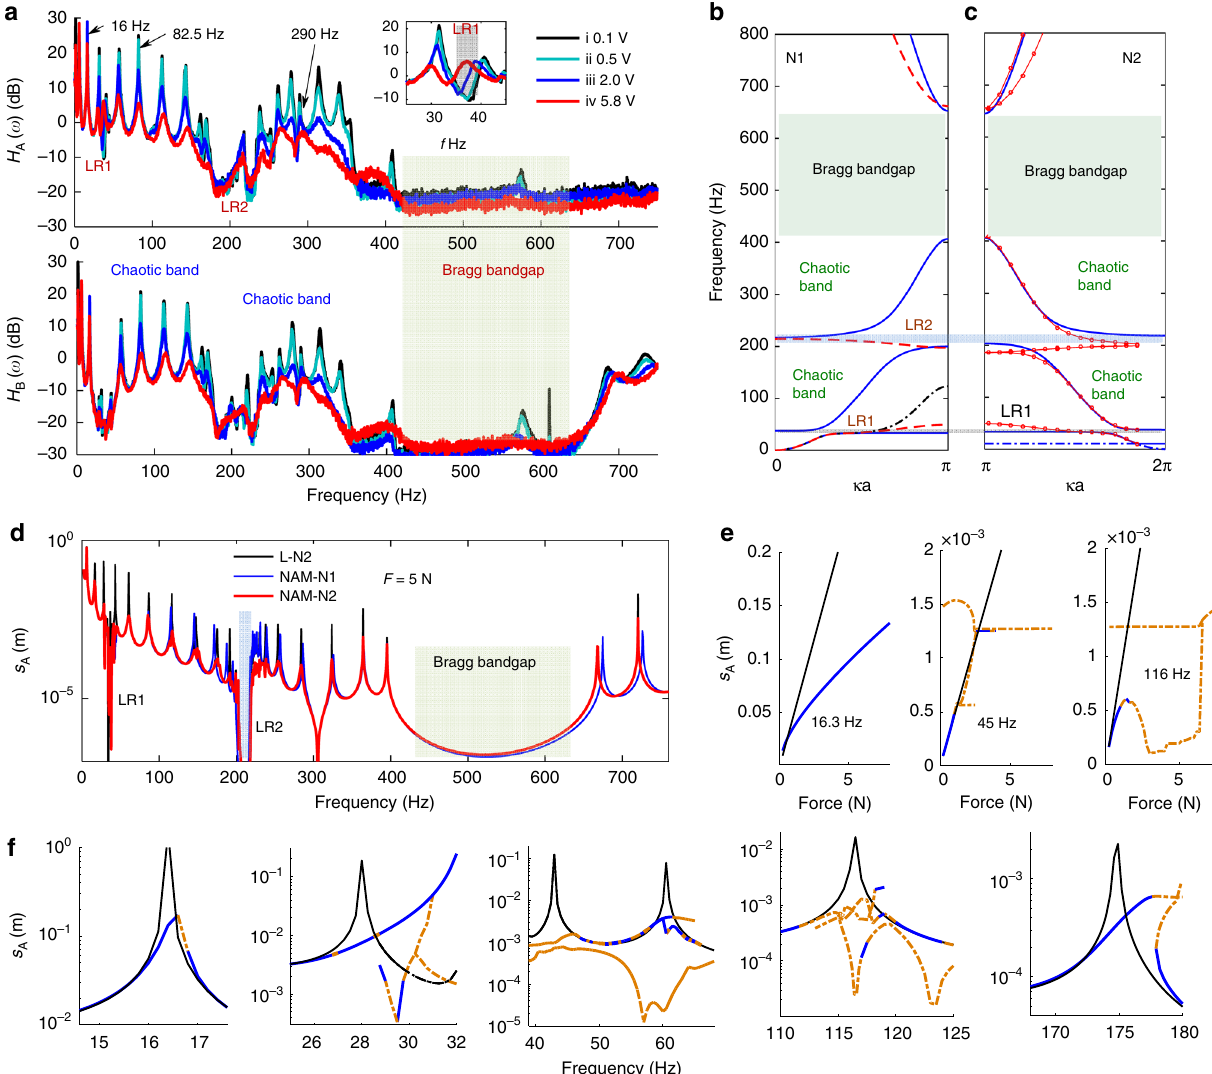
Fig. 3 Transfer functions, dispersion curves, responses and bifurcations of the NAM beam. a Transfer functions of points A and B under four levels of white-noise excitations. The average displacements in the interval (0, 20 Hz) represent the broadband excitation levels; (i: 0.1 V (the voltage of the ampli fi er), 1.06 × 10 − 3 mm (the average displacement), σ = 7.5 × 10 − 4 ≈ 0 (the nonlinearity strength)); (ii: 0.5 V, 6.453 × 10 − 3 , σ = 0.028); (iii: 2.0 V, 3.719 × 10 − 2 , σ = 0.9262); and (iv: 5.8 V, 7.936 × 10 − 2 , σ = 4.22). The small plot is the enlarged view near LR1. b , c Half dispersion curves of the ( b ) NAM- N1 and ( c ) N2. κ : the wave vector. In b , c , blue lines: LAM; red lines (black dashed line): the NAM solved with the harmonic balance method (HBM) (perturbation approach, PA) with displacement in case iv. In b , only the fi rst curve of the PA results and three curves of the HBM results are shown, because others superpose with the linear results. Three shadings denote the linear bandgaps. d Theoretical displacements at point A s A of the NAM N1, NAM N2 and the linearized LAM in case N2 (L-N2) based on the fi nite element method (FEM) and HBM (see Methods). In d , f , the driving force at point E is F = 5 N. e , f Bifurcation diagrams under e the changing force and f the changing frequency. Thin black lines: solutions of LAM; solid blue ( dashed yellow ): stable (unstable) periodic solutions of the